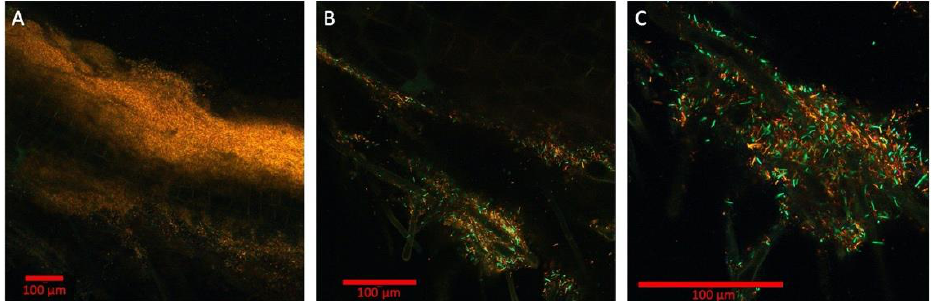
Figure 3. Multispectral imaging with 9 engineered strains of Pseudomonas simiae with constitutive expression of 9 fluorescent proteins: mTagBFP, mTurquoise2, EGFP, mVenus, mKO, mApple, mCherry, mKate2, and mCardinal. The magnifications shown are 10 × ( A ), 20 × ( B ), and 40 × ( C ), respectively. Bars are 100 μm. Colorized in Zen (Zeiss).